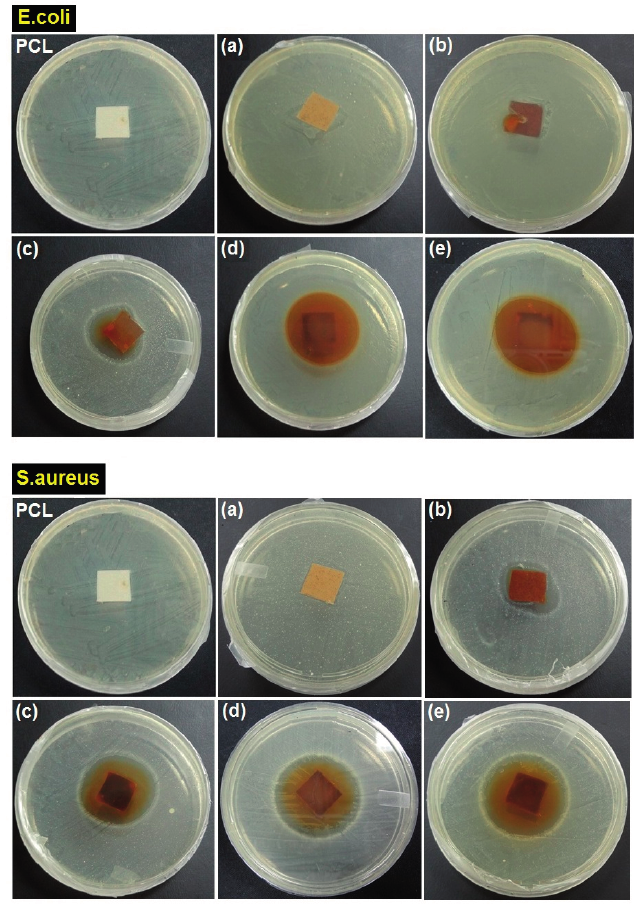
Figure 11. Inhibition zone of ORS/Fe 3 O 4 /PCL-NCs against Gram-negative ( E. coli ) and Gram-positive ( S. aureus ) bacteria at 1.0, 5.0, 15.0, 30.0 and 60.0 wt. % ORS/Fe 3 O 4 -NCs ( a – e ),